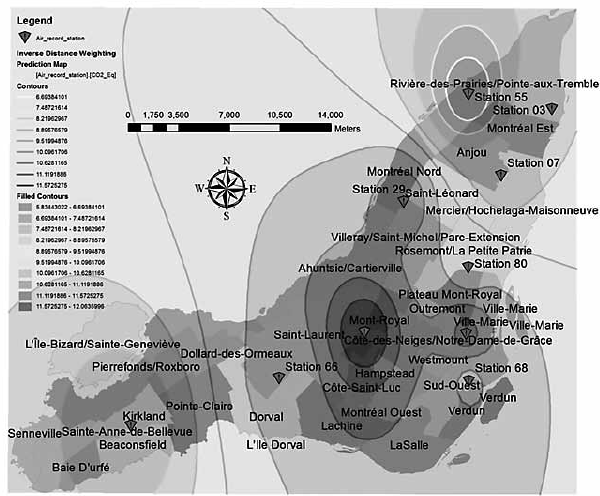
fig. 2. Geo-statistical analysis of Co2e GHG emissions index (million metric